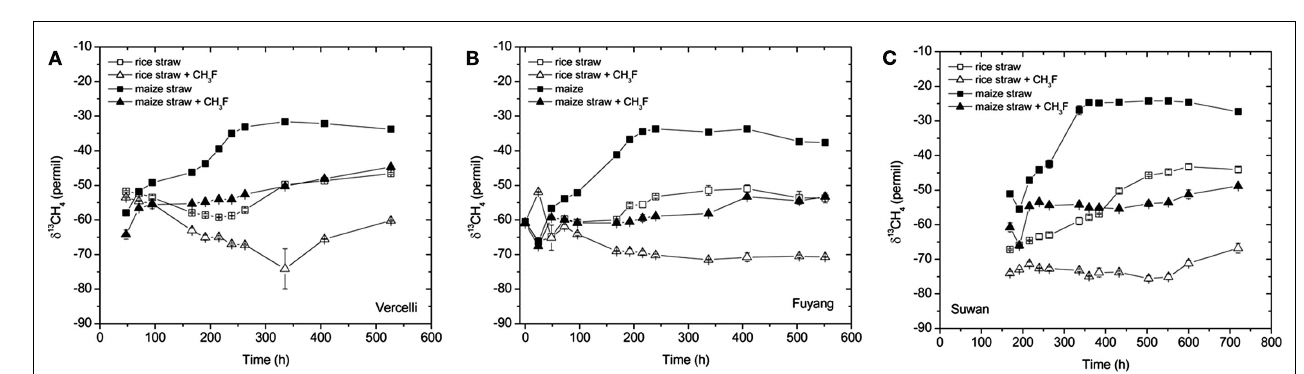
FIGURE 3 |Transient accumulation of H 2 in soil from (A)Vercelli, (B) Fuyang, and (C) Suwan, amended with either rice straw or maize straw and incubated under anoxic conditions in the absence or presence of